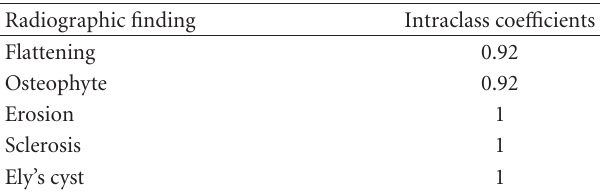
Table 8: Intraexaminer reliability.